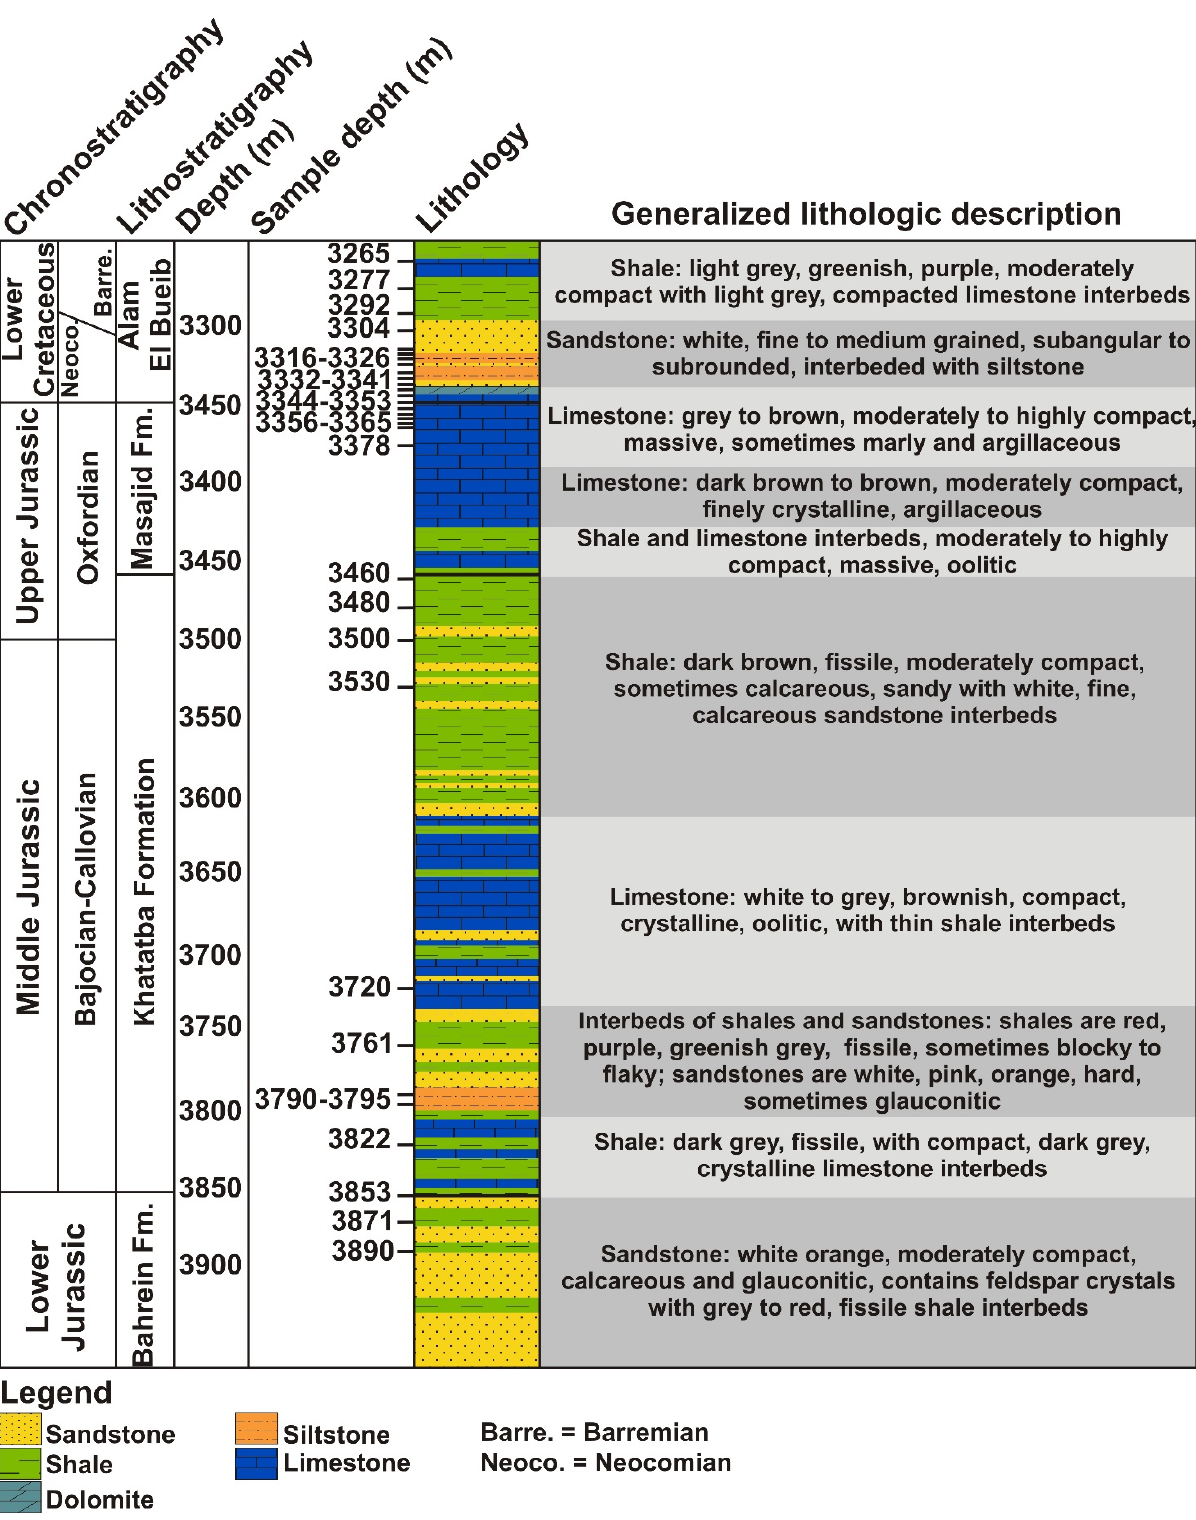
Figure 2. Lithostratigraphy and representative composite ditch cutting rock sample depths along with the generalized lithologic description of the Jurassic–Lower Cretaceous succession from the Almaz ‐ 1 well in the Shushan Basin, north Western Desert.